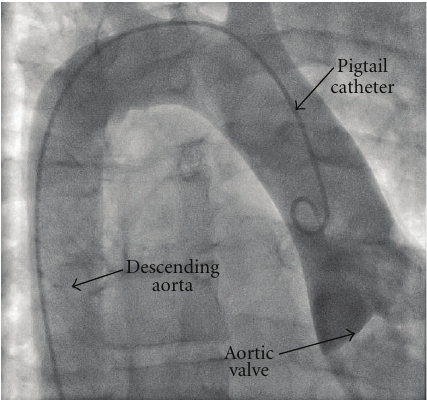
Figure 2: The aortic angiography performed during cardiac catheterisation confirms the dextrocardia and dextroposition of the aorta.